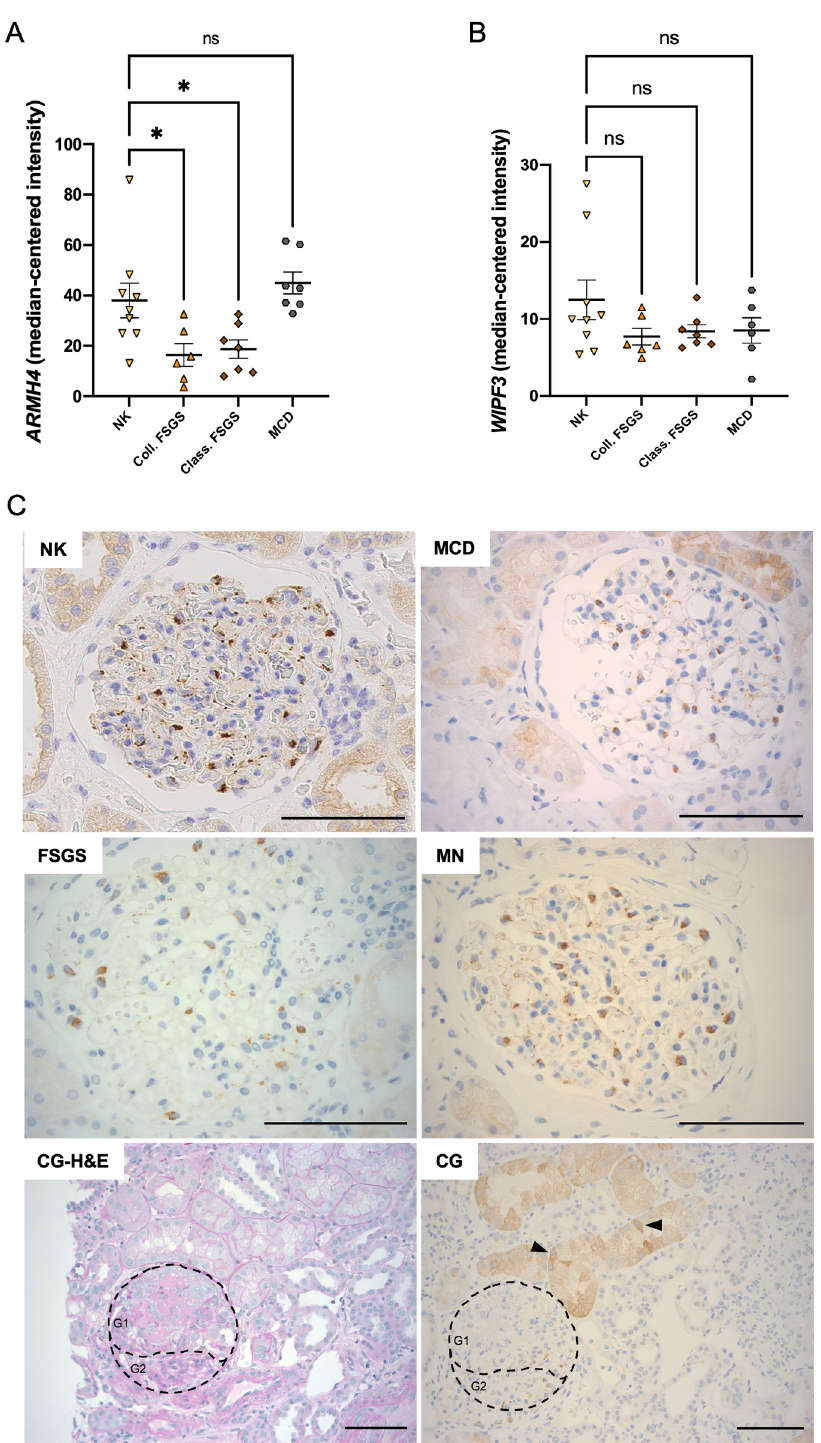
Fig 6. ARMH4 and WIPF3 in the healthy and disease state. A : the RNA level of ARMH4 is reduced in patients suffering from collapsing (coll.) and classic (class.) FSGS compared to normal kidney (NK), but not in those diagnosed with minimal change disease (MCD). The WIPF3 level, on the other hand, was not significantly different in any of the diseases ( B ). C : immunohistochemistry of glomeruli in patients diagnosed with MCD ( n = 2), FSGS ( n = 2), MN ( n = 2) and CG ( n = 2) suggests lower intensity of ARMH4 immunoreactivity vs. normal kidney (NK). In CG, ARMH4